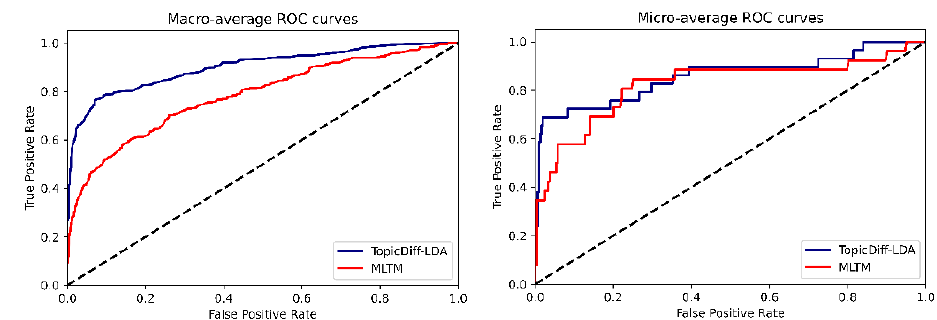
Figure 5. Multiple-labeling algorithm performance comparison.